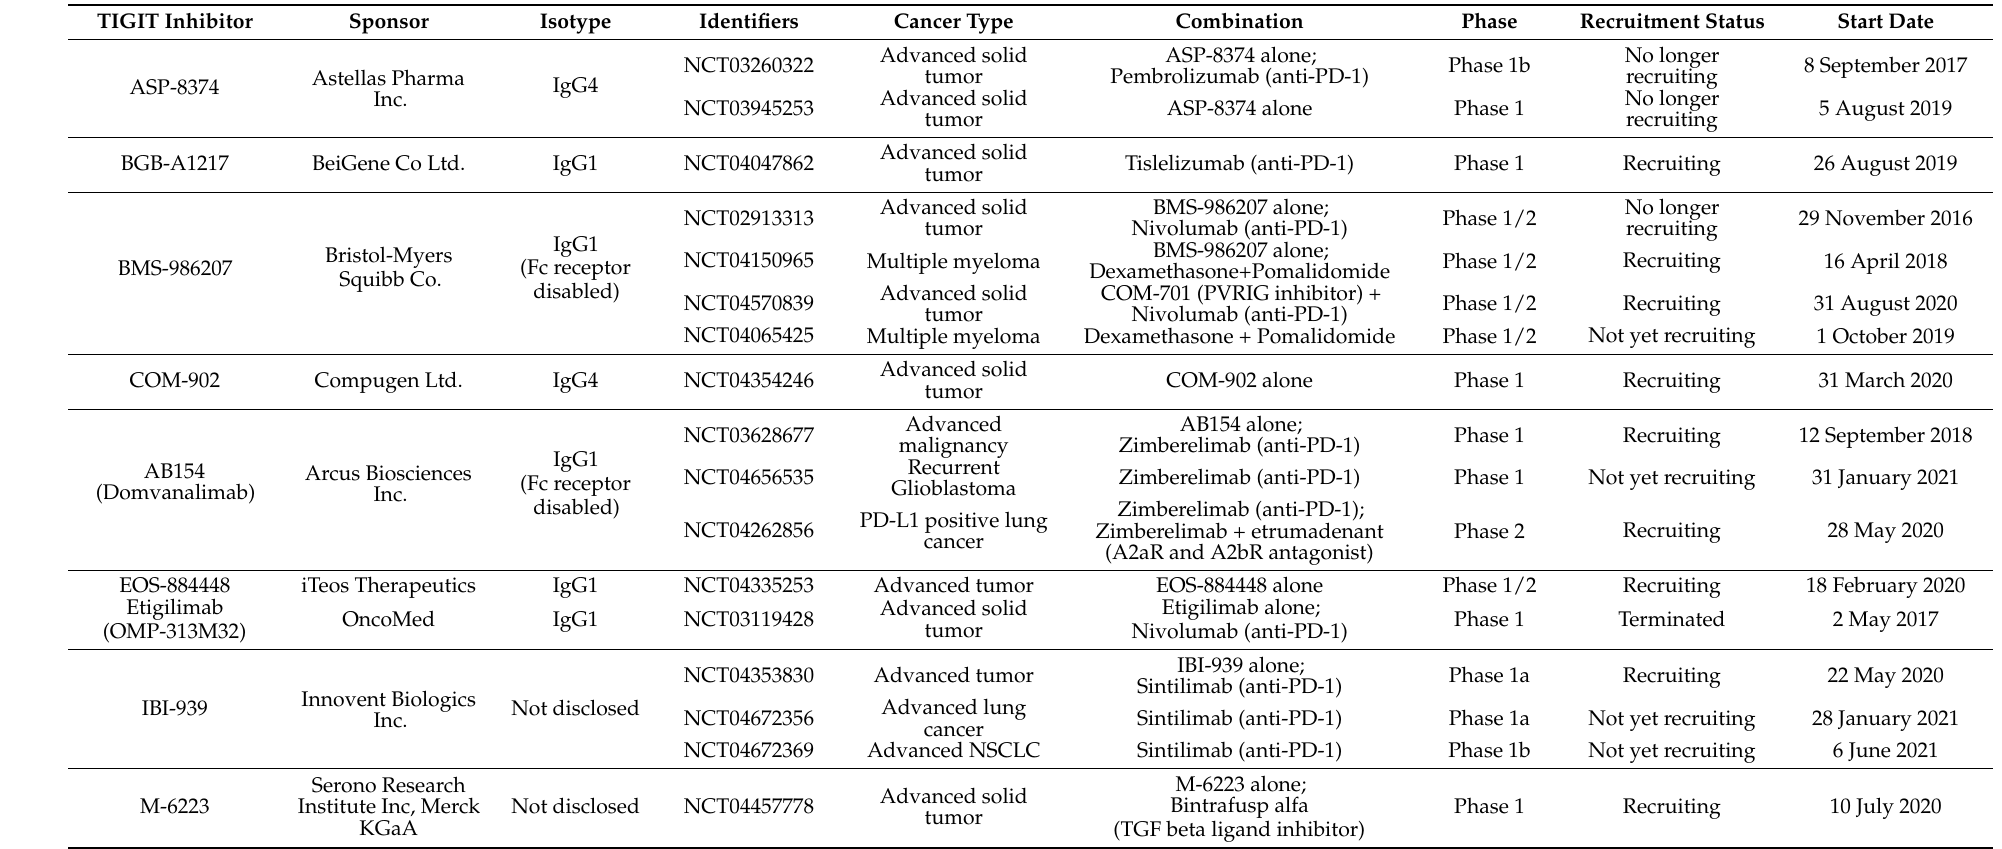
Table 1. Clinical trials of TIGIT